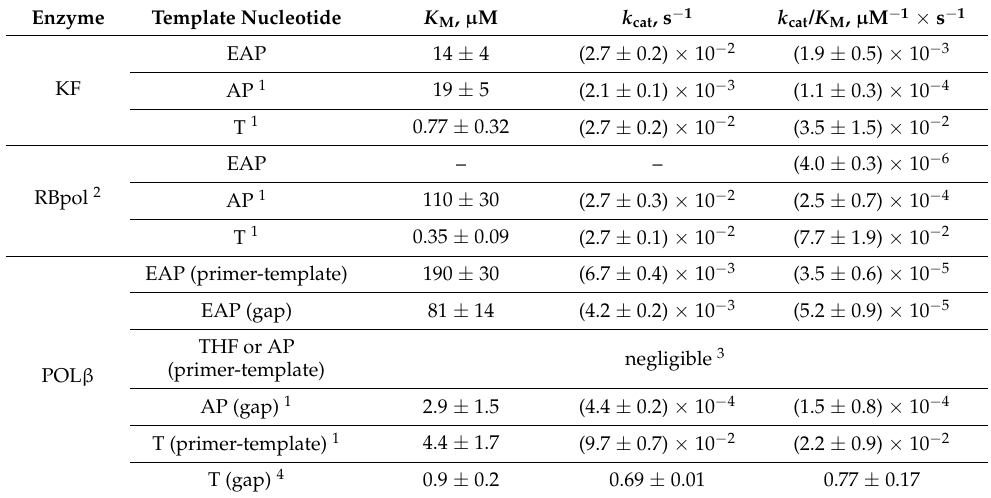
Figure 3. Kinetic curves of DNA polymerases incorporating dAMP opposite the template EAP. ( a ), KF; ( b ), RBpol; ( c ) , POLβ with a primer-template substrate; ( d ) , POLβ with a gapped substrate. Mean ± S.D. of three independent experiments is shown. Table 1. Kinetic parameters of the insertion of dAMP opposite abasic and undamaged template nucleotides.